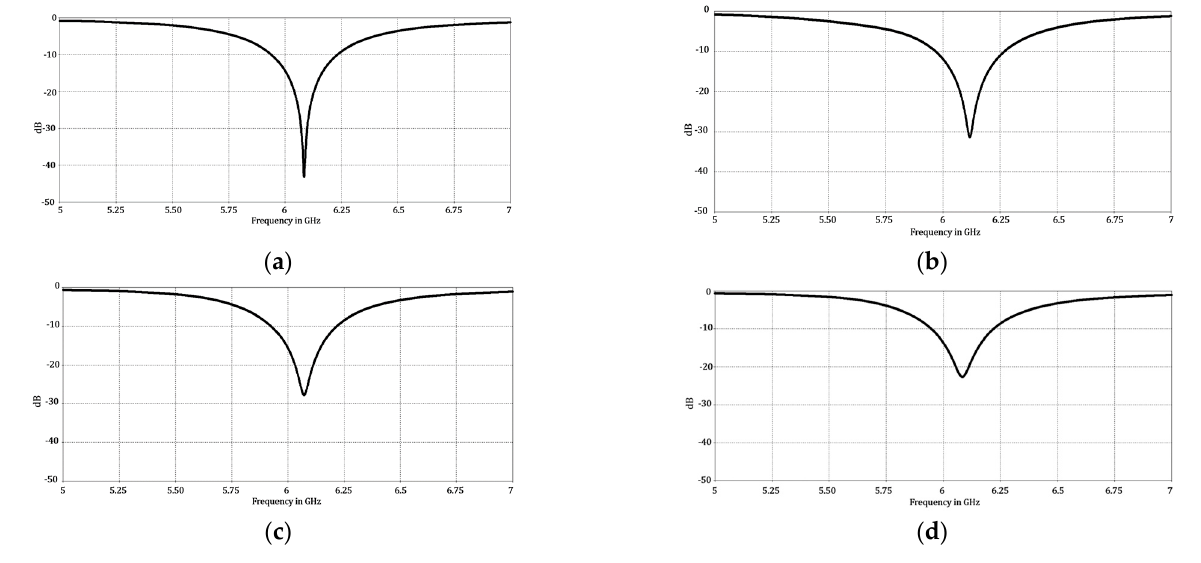
Figure 12. Behavior of the reflection coefficient versus frequency for all proposed design cases of the Fermat spiral, as follows: ( a ) golden angle, ( b ) angle optimization, ( c ) raised cosine and ( d ) amplitude optimization.